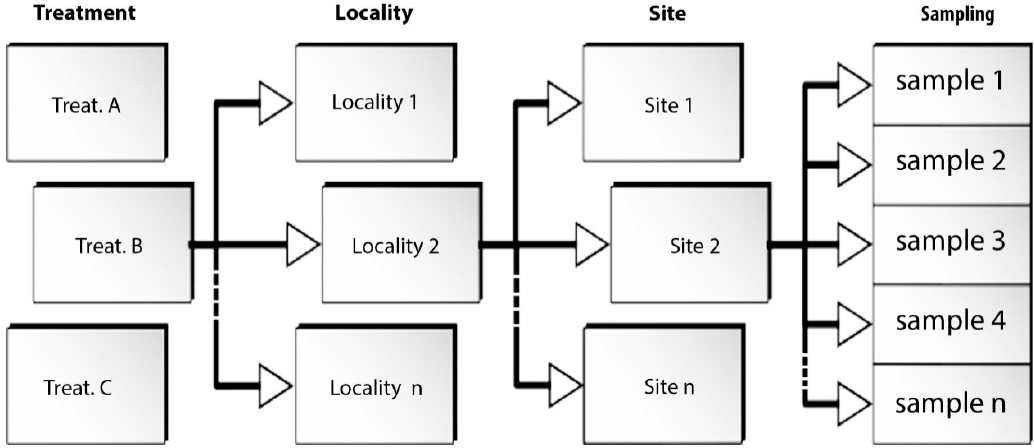
Figure 3. Spatial arrangement of experimental data (general design). Locations were set to minimize substrate differences (homogeneous features, rock type, exposure, etc .); sites (corresponding to shore platforms) were randomly selected within the localities.